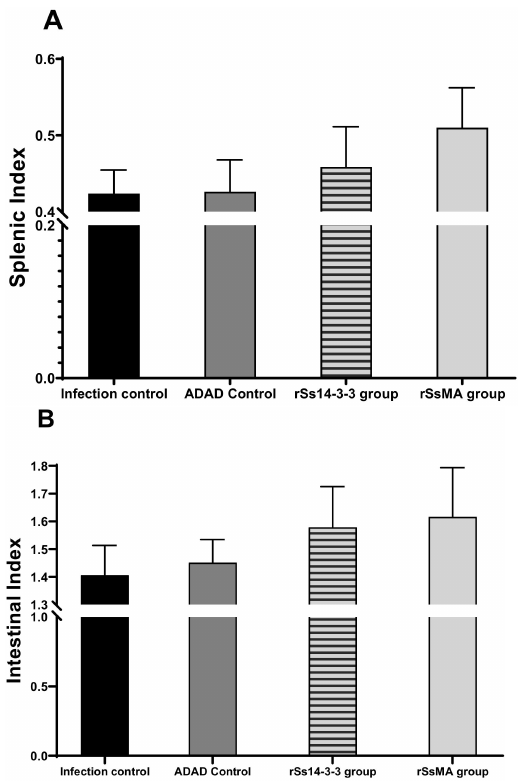
Figure 4. Effect of the immunization in the Splenic ( A ) and Intestinal ( B ) indexes af- ter infection of mice with S. venezuelensis . Bars represent means ± SEM. Data were eval- uated by one-way ANOVA analysis against infection and ADAD controls, but there were not significant differences (F (3,28) = 0; p = 0.5086 for the splenic index and F (3,28) = 0.5649; p = 0.6427 for the intestinal